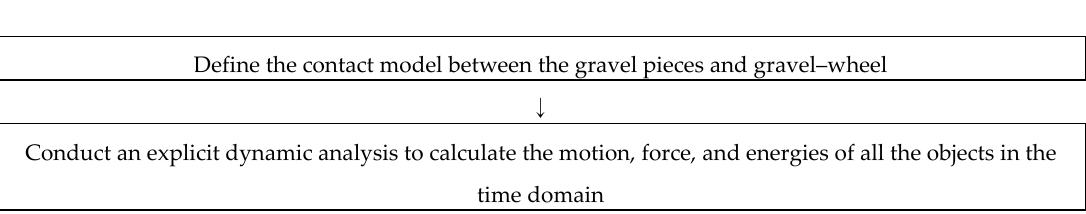
Figure 7. Simulation procedure for ballast–wheel collision.